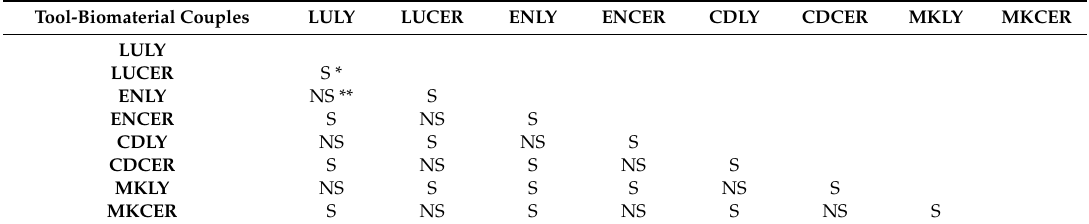
Table 4. Kruskal-Wallis statistical test results for Ra 2D roughness criterion.